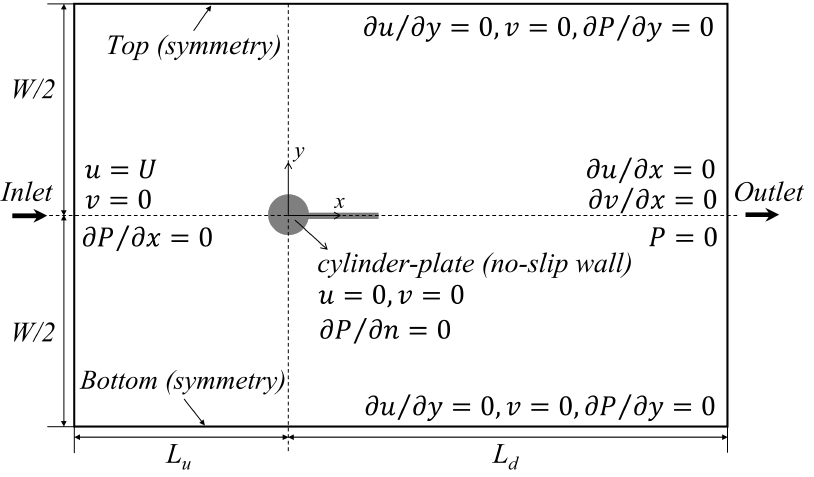
Figure 2. Sketch definition of computational domain and boundary conditions used in the numeri- cal